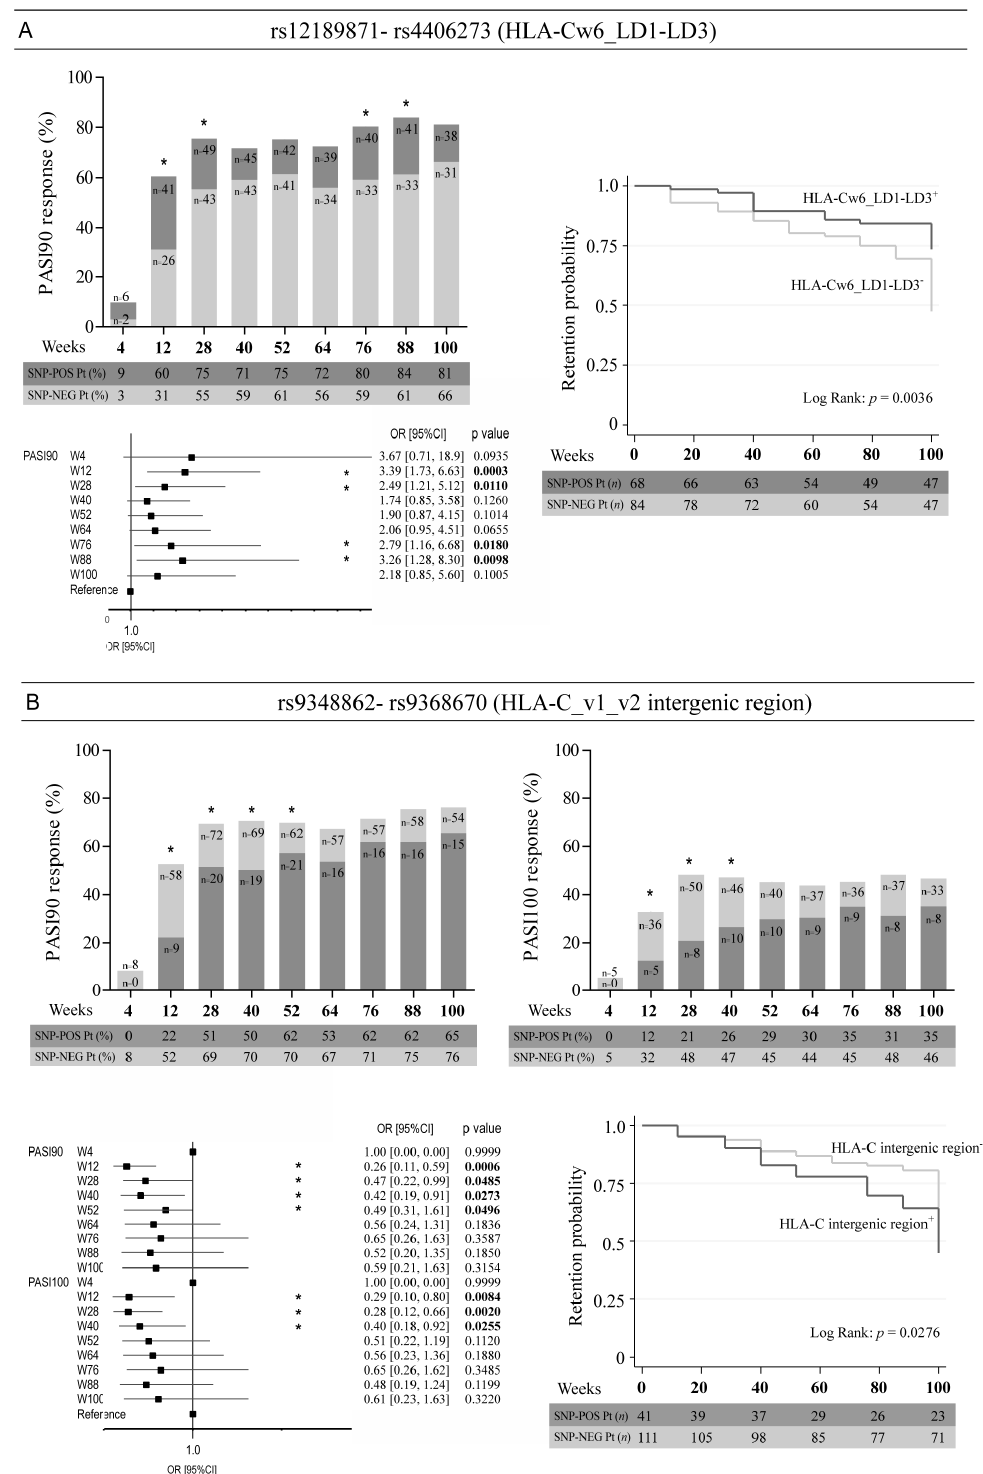
Figure 2. Association analysis between rs12189871, rs4406273, rs9348862 and rs9368670 SNPs in HLA ‐ C intergenic region and clinical responses to ustekinumab treatment. Univariate logistic regression analysis was performed to evaluate the association between ( A ) rs12189871 (HLA ‐ Cw6_LD1) or rs4406273 (HLA ‐ Cw6_LD3) and ( B ) rs9348862 (HLA ‐ C_v1 intergenic region) or rs9368670 (HLA ‐ C_v2 intergenic region) with the clinical response to ustekinumab after 4, 12, 28, 40, 52, 64, 76, 88 and 100 weeks of treatment, in a cohort of patients ( n = 152) affected by moderate ‐ to ‐ severe psoriasis. Graphs show the percentage of patients carrying (dark grey bars) or not (light grey) the SNPs and achieving 90% reduction of PASI (PASI90) ( A , B ) and 100% reduction (PASI100) ( B ). Rs12189871, rs4406273 ( A ) and rs1131118 (HLA ‐ Cw6) (not shown), as well as rs9348862 and